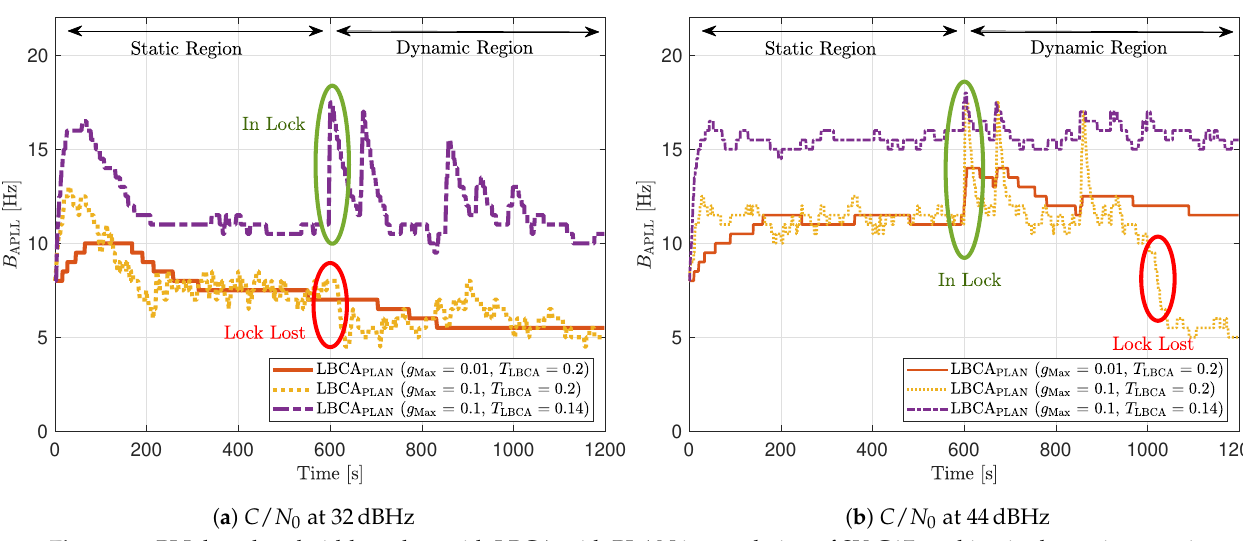
Figure 35. PLL loop bandwidth update with LBCA with PLAN interpolation of SV G17 tracking in dynamic scenario.